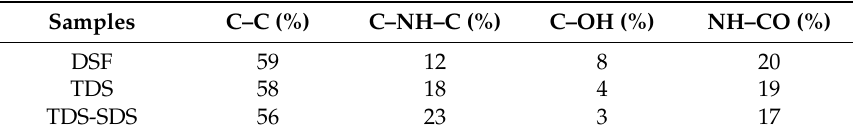
Table 1. Structure contents of the defatted soybean flour (DSF), TDS, and TDS-sodium dodecyl sulfate (SDS) samples by X-ray photoelectron spectroscopic (XPS)